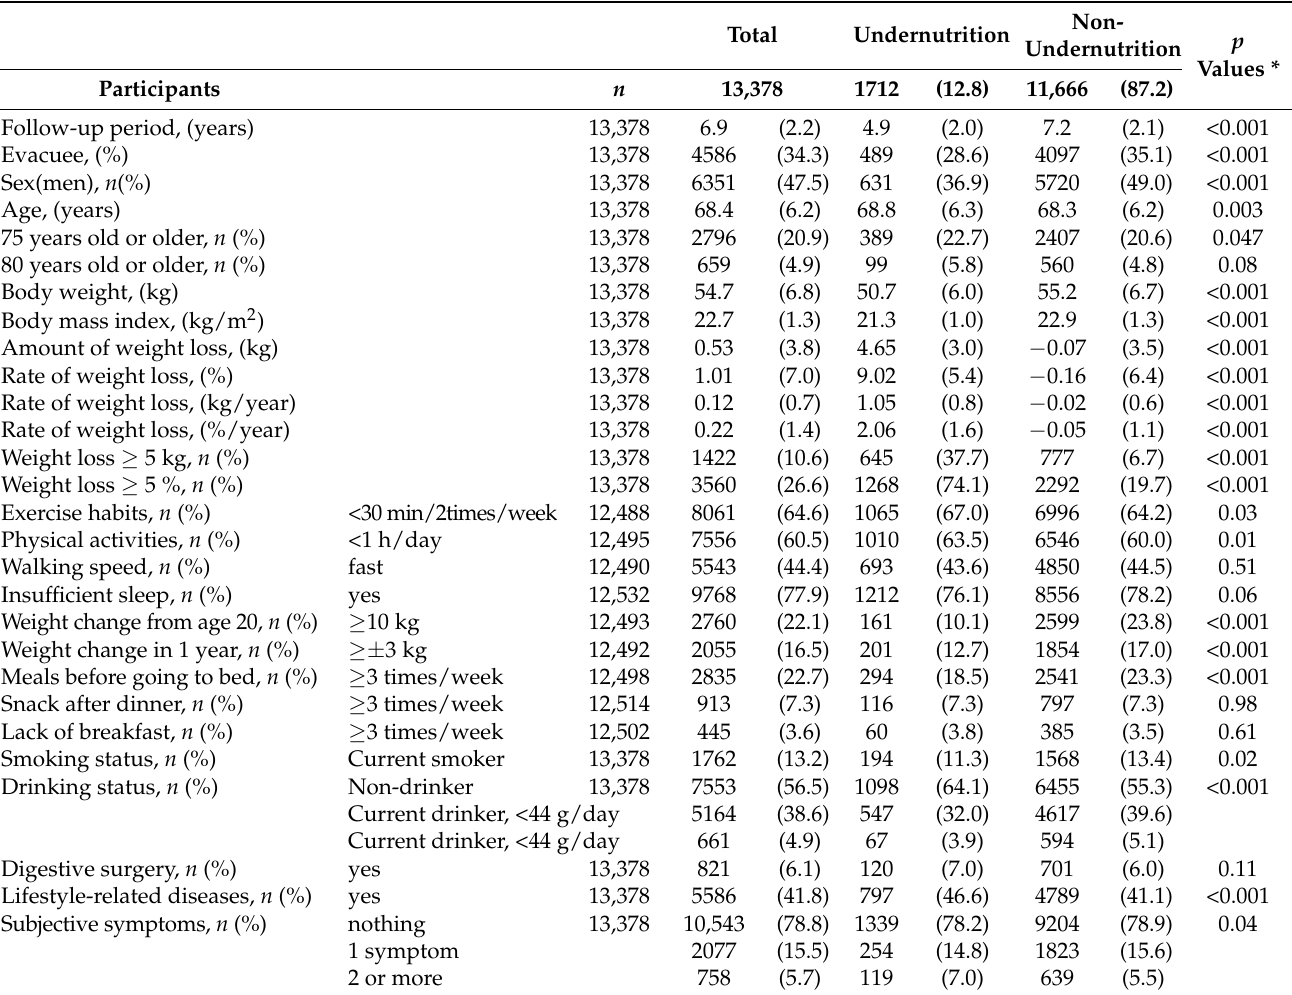
Table 1. Characteristics at baseline of 13,378 participants with and without incident of